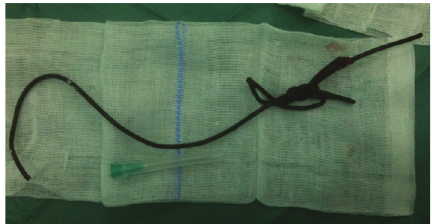
Figure 3: The foreign body (television cable) after extraction: Small amounts of tissue, characterized as inflammatory reaction were found at the refractory